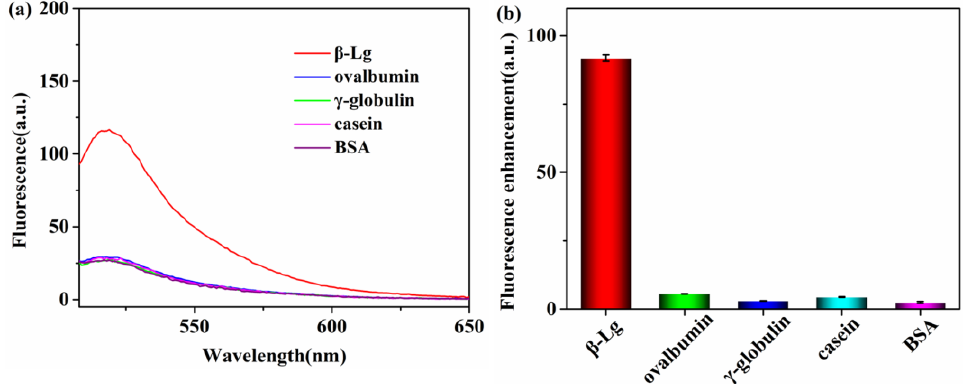
Figure 6. Selectivity of the method. ( a ) Fluorescence emission spectra of the system in the presence of different proteins. ( b ) Fluorescence changes of the system toward β-Lg and other interfering proteins.